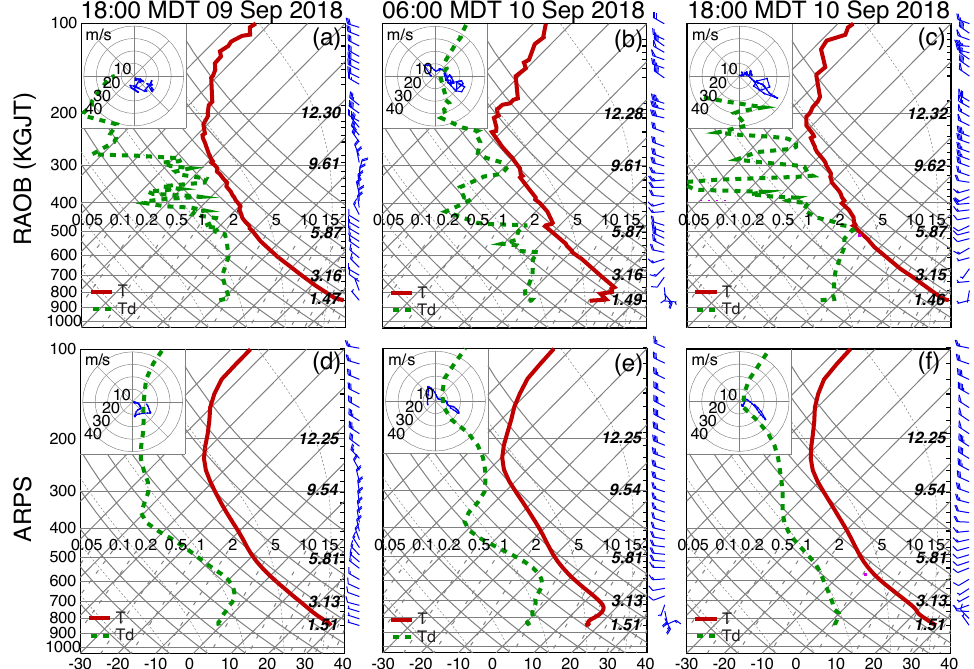
Figure 2. Skew T–log P comparison of ( a – c ) KGJT rawinsonde sounding, and ( d – f ) D1 model sounding at the nearest grid point to KGJT. In all panels, the red line is temperature and the green line is dewpoint; the blue curve in the top-left corner of each panel indicates the hodograph trace. The values on the x-axis and y-axis denote temperature (°C) and atmospheric pressure (hPa), respectively; approximate height above mean sea level (km) is indicated for select pressure levels on right side of each panel. Location of KGJT is indicated by a red circle in Figure